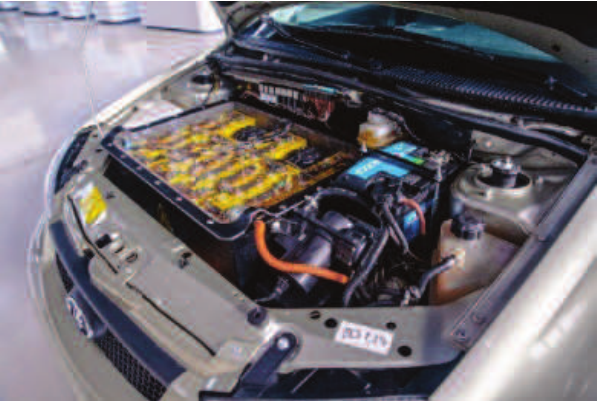
Fig. 5. General view of the engine compartment with the developed system of accumulation and storage of electrical energy